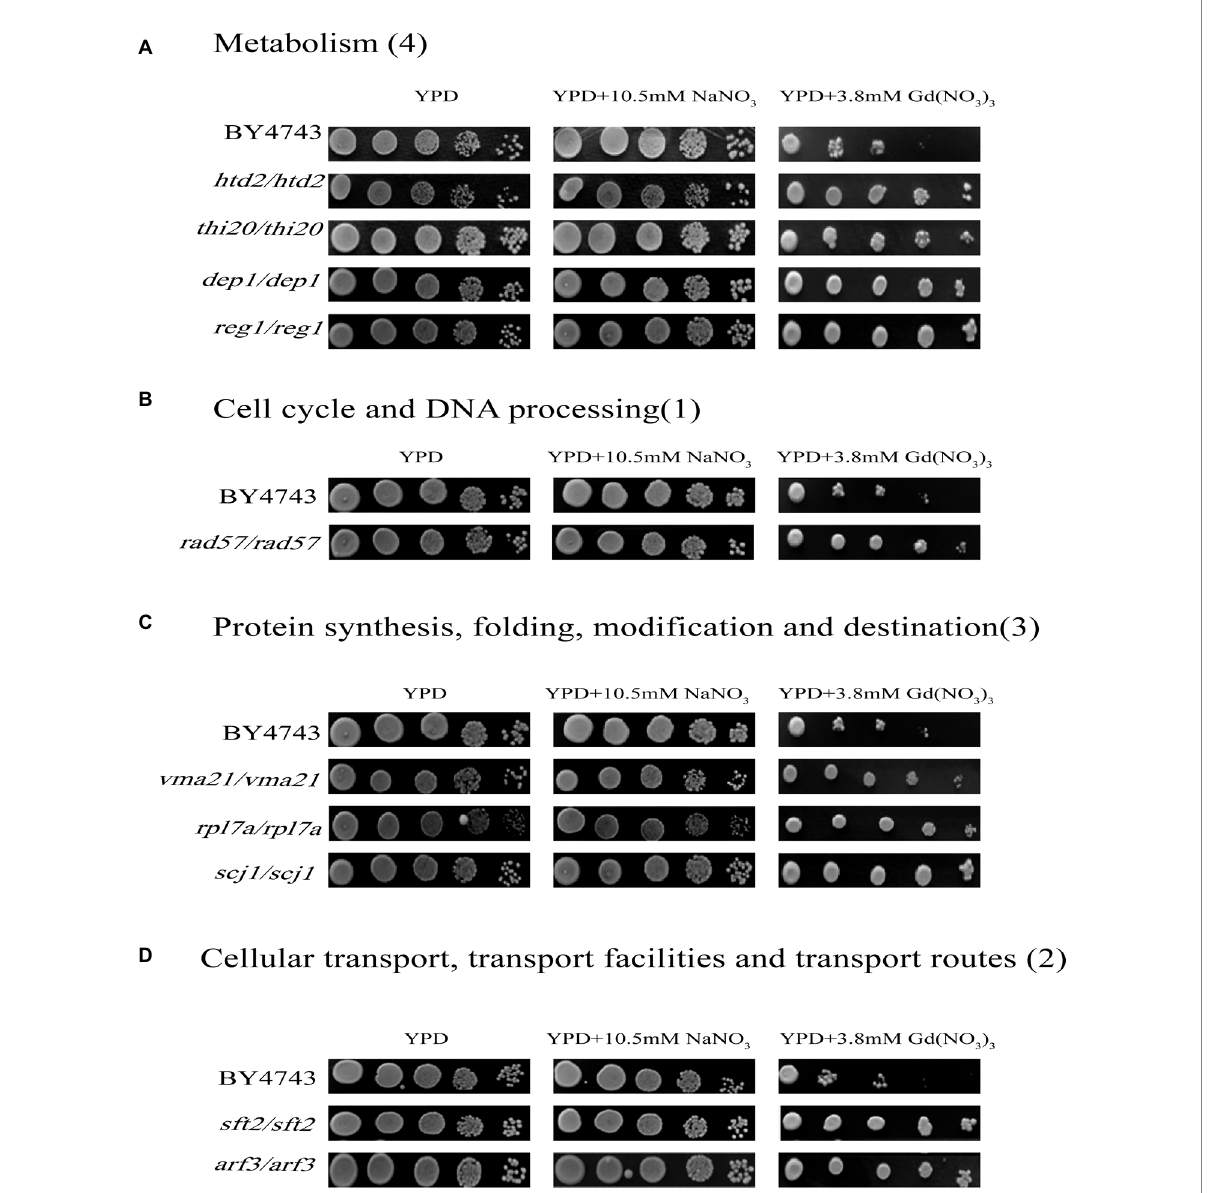
FIGURE 3 Phenotypes of Gd-resistant gene deletion mutants. Five yeast culture diluents (10 − 0 , 10 − 1 , 10 − 2 , 10 − 3 , 10 − 4 ) were put on the YPD solid medium containing 0, 3.8 mM Gd(NO 3 ) 3 , and 10.5 mM NaNO 3 , respectively. Cells of the wild-type BY4743 and 10 gene deletion mutants were identified from the genome-scale screen, and functional categories of the genes corresponding to the resistant phenotypes were classified. (A) Metabolism (4 genes); (B) DNA processing and cell cycle (1 gene); (C) Protein synthesis, modification, folding, and destination (3 genes); (D) Cellular transport, transport routes, and transport facilities (2 genes). The experiment was repeated three